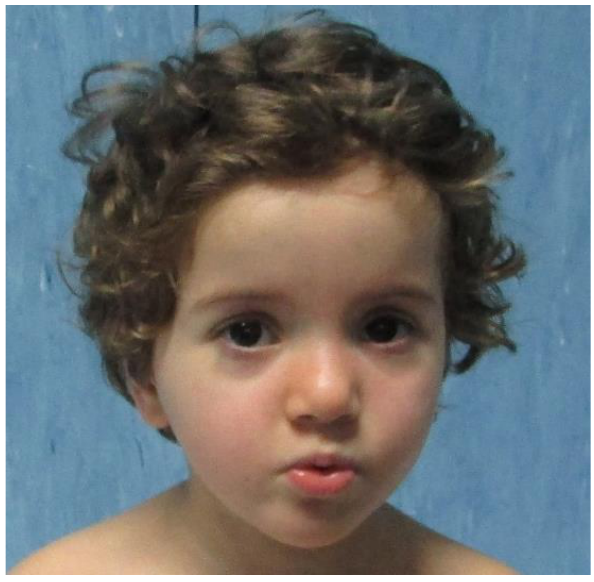
Figure 1. Clinical photographs of our patient at first clinical examination.